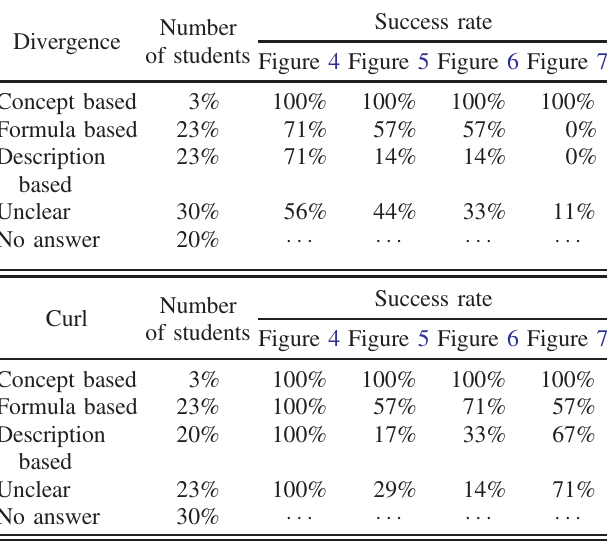
TABLE II. The prevalence and success rate of strategies students used to determine the divergence and curl of vector fields based on graphical representations used in the pretest ð N ¼ 30 Þ